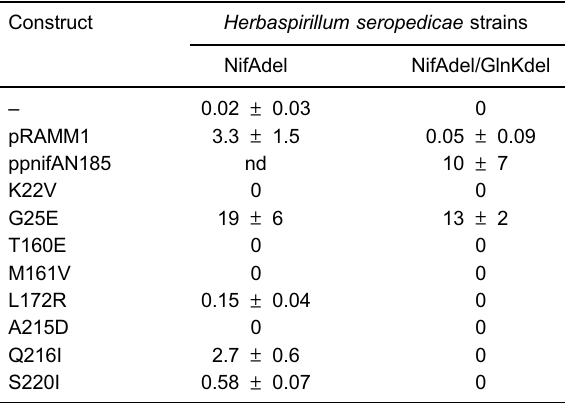
Table 2. Effect of NifA mutations on H. seropedicae nitrogenase